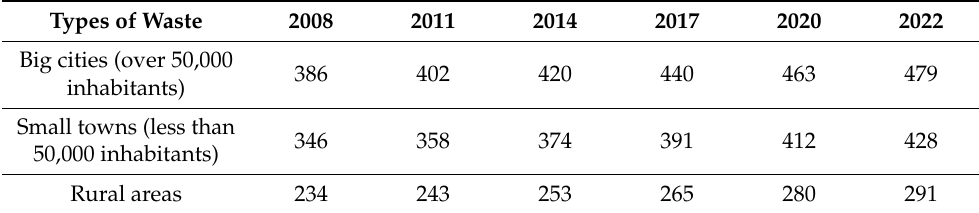
Table 1. Projected changes in the unit index of municipal waste generation (in kg/M/year)